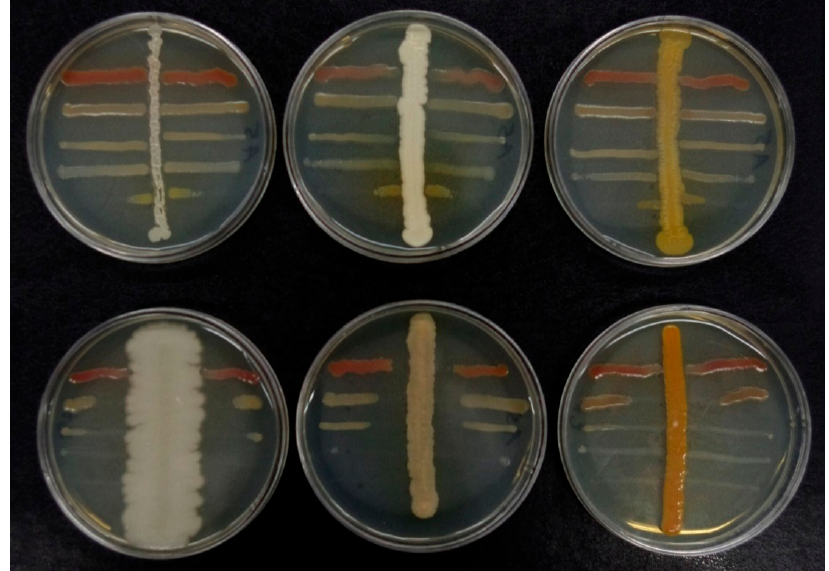
Figure 1. Interactions between M. melolontha midgut isolates and nematode bacteria in cross-streak test. Horizontal streaks—five entomopathogenic bacteria (EPB) strains, vertical streak—midgut isolate. Top row—no inhibition effect; bottom row—isolates with high antibacterial activity against EPB.